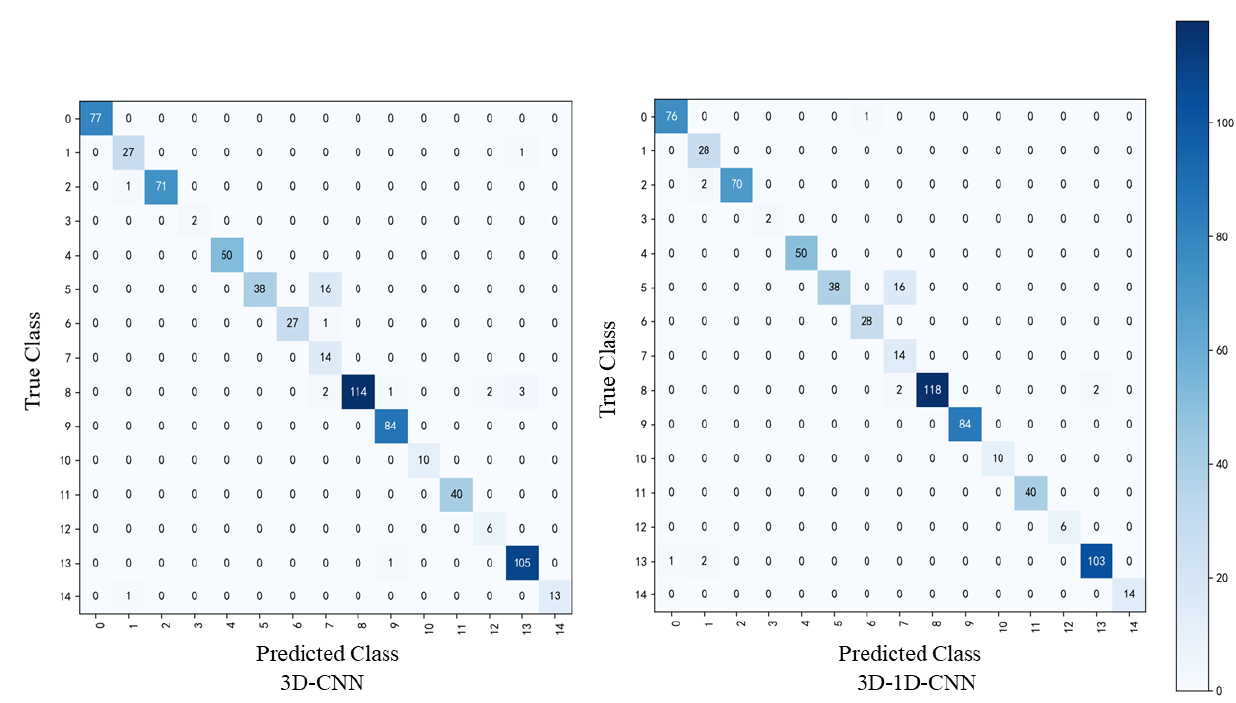
Figure 17. Confusion matrix comparison of different models on the Houston dataset.